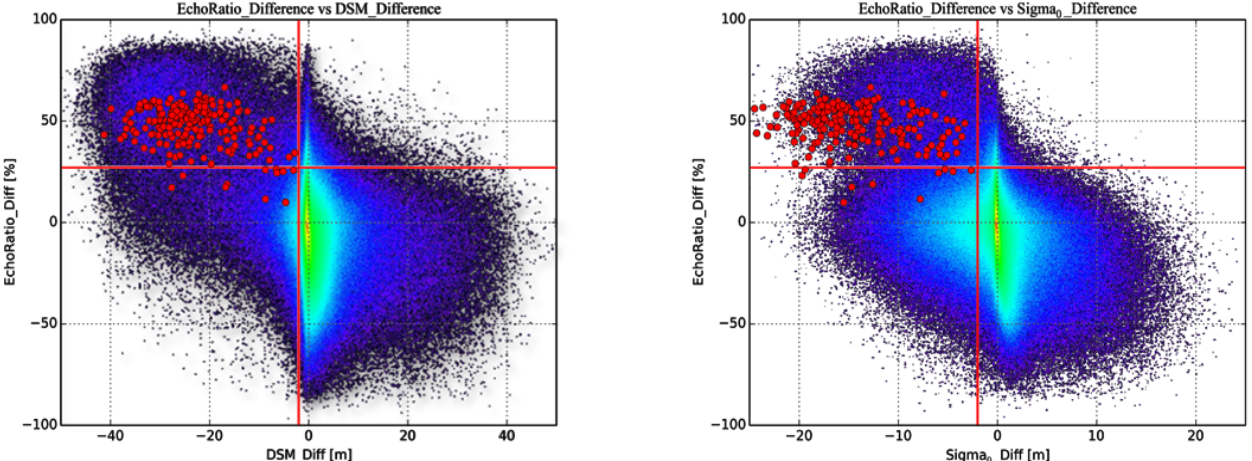
Figure 4. Feature space of ( a )  sER versus  Sigma 0 ; ( b )  sER versus  DSM. The red lines indicate the threshold values for change detection. Brighter colors denote a higher density of points (from blue, to green, to red). Red dots indicated the median value of  DSM,  sER, and  Sigma 0 of the reference